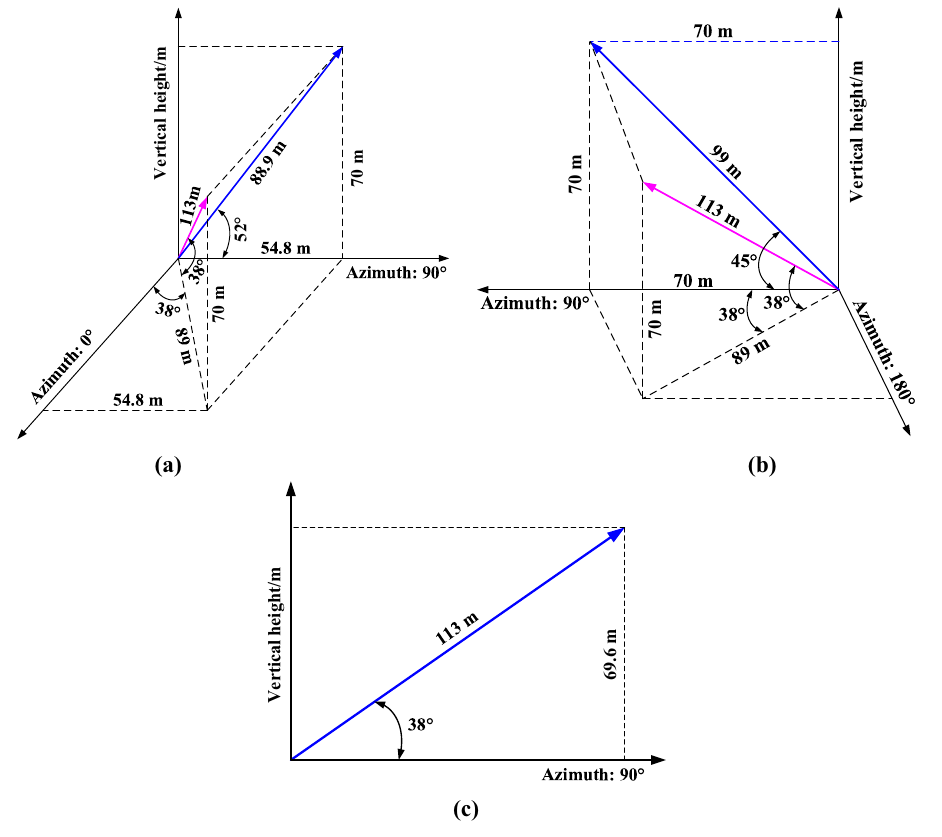
Figure 9. Three-dimensional diagram of detection boreholes: ( a ) Borehole B1, ( b ) Borehole B2 and ( c ) Borehole